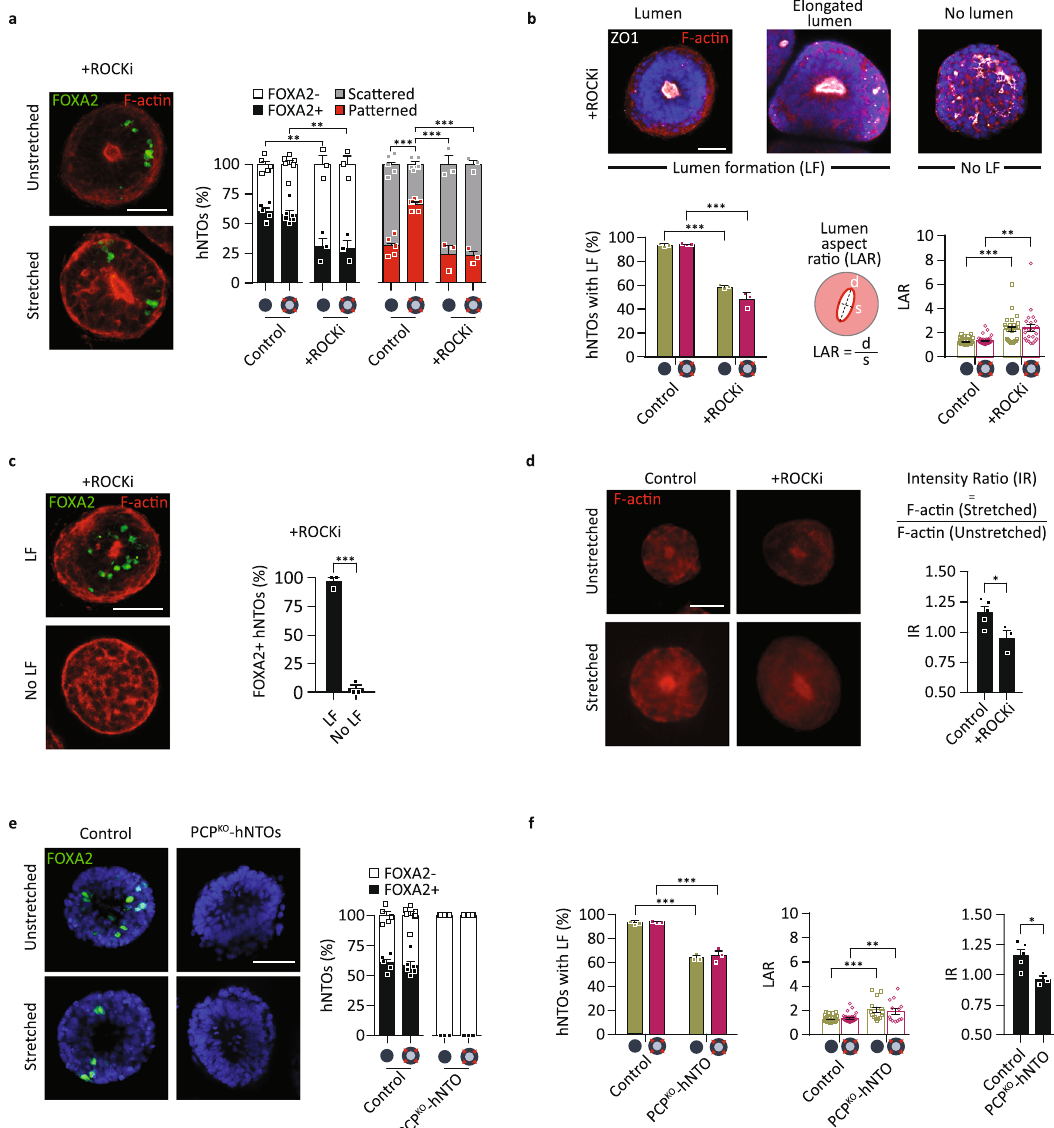
Fig. 5 Contractility and planar cell polarity determine fl oor plate induction and hNTO patterning. a Representative images of FOXA2 and F-actin expression in stretched and unstretched hNTOs with prolonged ROCKi exposure, and quanti fi cation of FP induction and patterning upon stretch compared to control conditions ( n = 3 for unstretched (222) and stretched (187) hNTOs, control hNTOs from Fig. 1d, statistical analysis was determined by unpaired two-sided t -test (FOXA2 + control unstretched-ROCKi unstretched p = 0.0023, FOXA2 + control stretched-ROCKi unstretched p = 0.0035, patterned control stretched-control unstretched p < 0.0001, patterned control stretched-ROCKi unstretched p = 0.0006, patterned control stretched-ROCKi stretched p < 0.0001)). b Representative images showing F-actin and ZO1 expressions for hNTOs exposed to 10 µ M of ROCKi for 11 days. Quanti fi cation of the number of hNTOs exhibiting lumen formation (LF) and lumen aspect ratio (LAR) ( n = 3 for >25 hNTO per condition, statistical analysis was determined by unpaired two-sided t -test for LF (unstretched p < 0.0001, stretched p = 0.0007) and unpaired two-sided t -test with Welch ’ s correction for LAR (unstretched p < 0.0001, stretched p = 0.0018)). c Representative images and quanti fi cation showing FOXA2 expression in hNTOs with and without LF ( n = 3 for >30 hNTOs, statistical analysis was determined by unpaired two-sided t -test p < 0.0001). d Representative hNTO images indicating F-actin expression, with quanti fi cation of F-actin intensity within the organoid. Intensity ratio (IR) quanti fi es the relative F-actin intensity within organoids between stretched and unstretched samples ( n = 3 for >25 hNTOs per condition, statistical analysis was determined by unpaired two-sided t -test p = 0.0382). e Representative images and quanti fi cation highlighting the absence of FOXA2 expression in PCP KO -hNTOs compared to control hNTOs under unstretched and stretched conditions ( n = 3 for >50 PCP KO -hNTOs, control hNTOs from Fig. 1d). f Quanti fi cation of LF, LAR, and IR for PCP KO -hNTOs (n = 3 for >30 PCP KO -hNTOs per condition, statistical analysis was determined by unpaired two-sided t -test for LF (unstretched p < 0.0001, stretched p = 0.0008), by unpaired two-sided t -test with Welch ’ s correction for LAR (unstretched p = 0.0037, stretched p = 0.0011), and by unpaired two-sided t -test for IR p = 0.0273)). Error bars are SEM, scalebars 50 µ m.